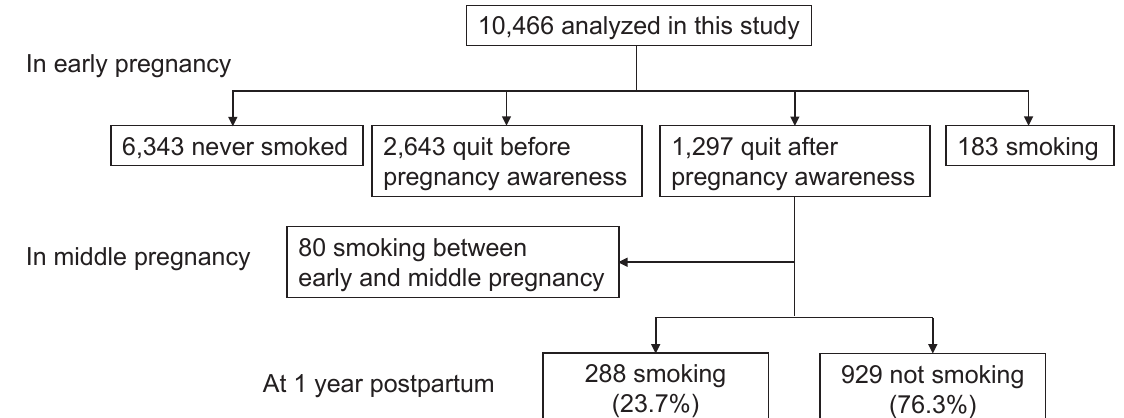
Figure 1. Flow diagram of participants ’ smoking